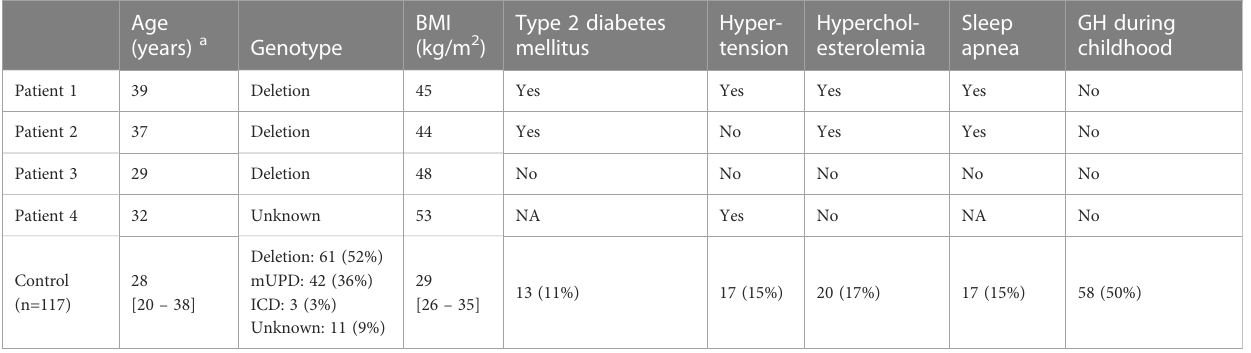
TABLE 1 Patient characteristics, cardiovascular risk factors and childhood GH status of four patients with PWS with cardiovascular events, compared to 117 PWS adults without cardiovascular